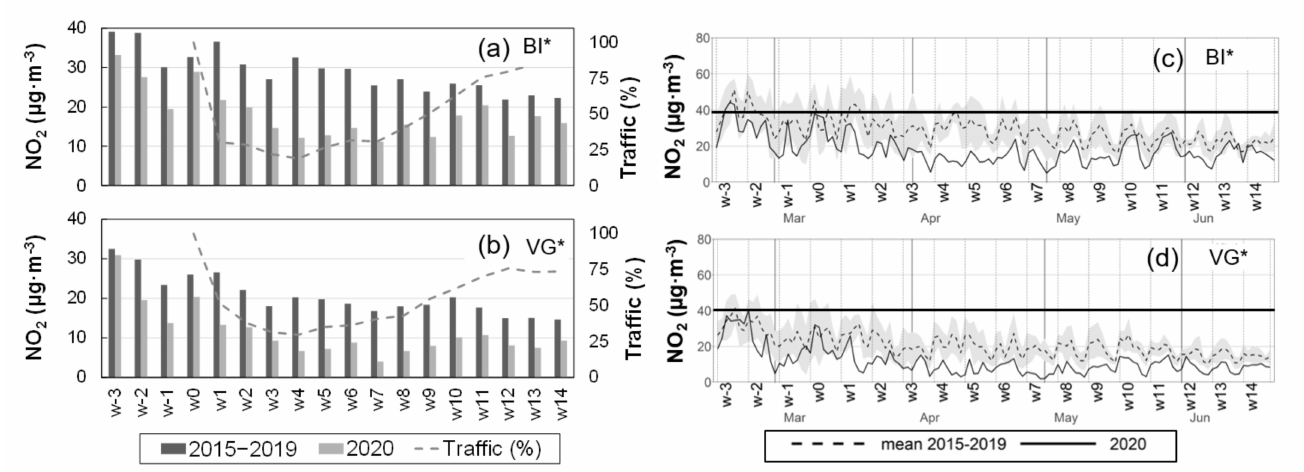
Figure 4. ( Left ) Weekly NO 2 averages during the March–June (2020) lockdown period and the corresponding 2015 − 2019 inter-annual averages for the urban BI* ( a ) and VG* ( b ) monitoring stations. Dashed lines in the same panels represent the percentage change in weekly traffic during the lockdown compared to week 0. ( Right ) NO 2 daily averages during the lockdown (solid line) and the inter-annual averages (dashed) with the standard deviation (gray shading) for the same two cities BI* ( c ) and VG* ( d